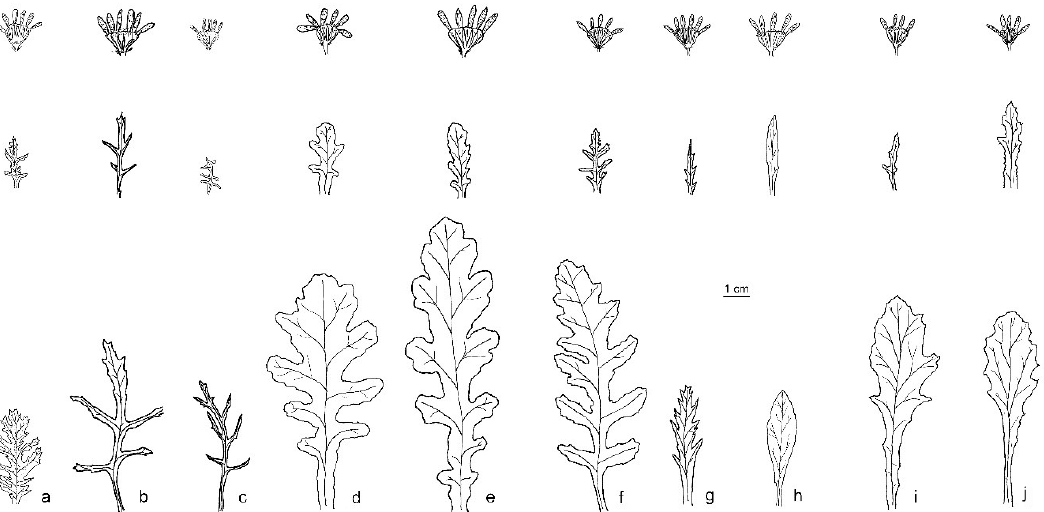
Figure 1. Schematic drawings of capitula, upper leaves, and basal leaves of the studied taxa of Senecio from the original material or specimens collected in the type localities: ( a ) S. aknoulensis (MPU000224); ( b ) S. squalidus (Herb. Linn. No. 996.33, LINN); ( c ) S. siculus ( Senecio siculus , chrysanthemifol . Cyr. (TO ex Herb. Allioni); ( d ) S. balansae (P02685431); ( e ) S. duriaei (K000852081); ( f ) S. rupestris (L3657828); ( g ) S. × glaber (CAT23508); ( h ) S. aethnensis (G00471538); ( i ) S. calabrus (FI066024); ( j ) S. sardous (TO4025). Drawings by G.